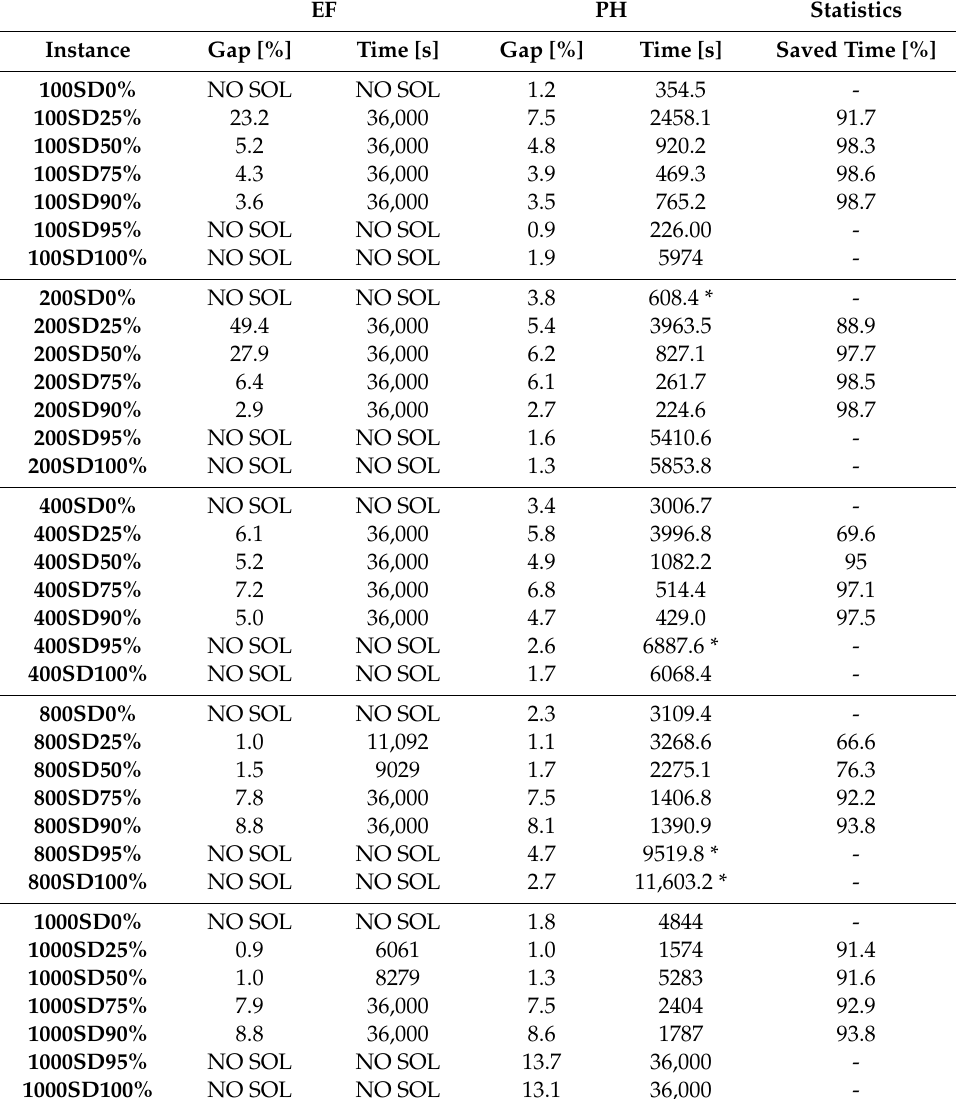
Table 1. Comparison of performance of PH algorithm (PH) versus the extended formulation with CPLEX (EF) for all the instances including adjacency restriction and demand levels D. PH gap is computed using the best bound given by CPLEX when solving EF. The results shown in this table are the averages found for each of the 15 forests generated for each instance. NO SOL means that